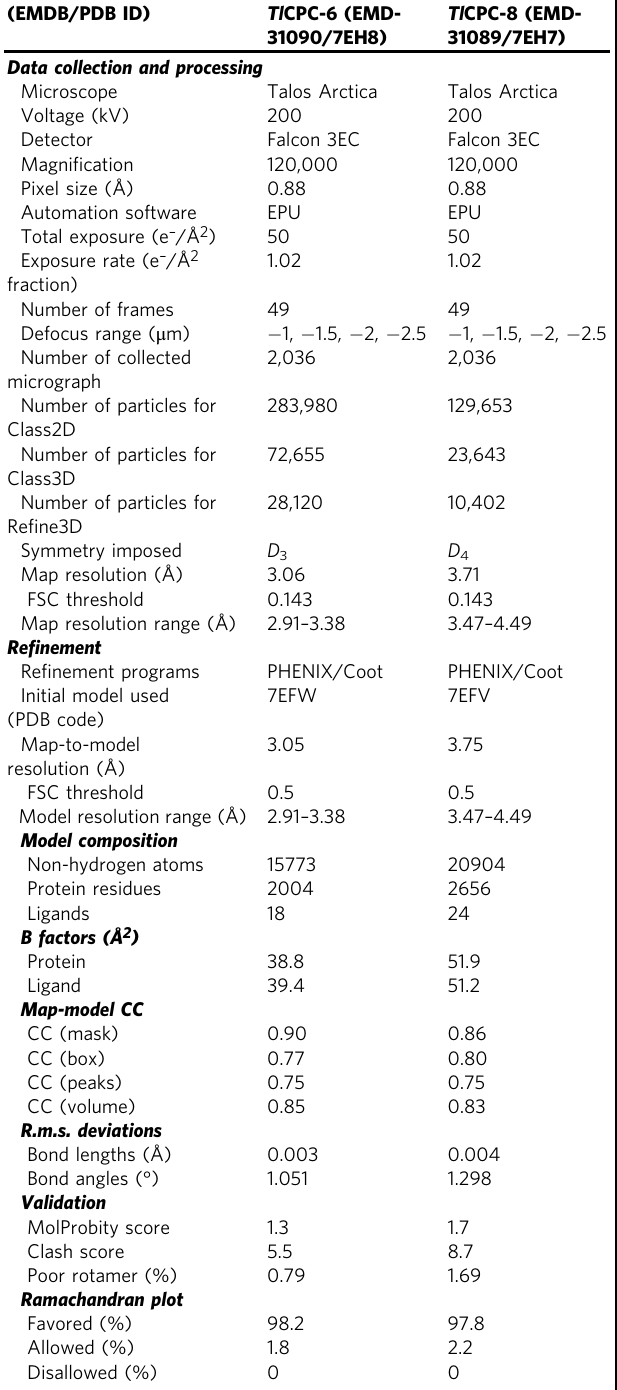
Table 2 Cryo-EM data collection, re fi nement, and validation